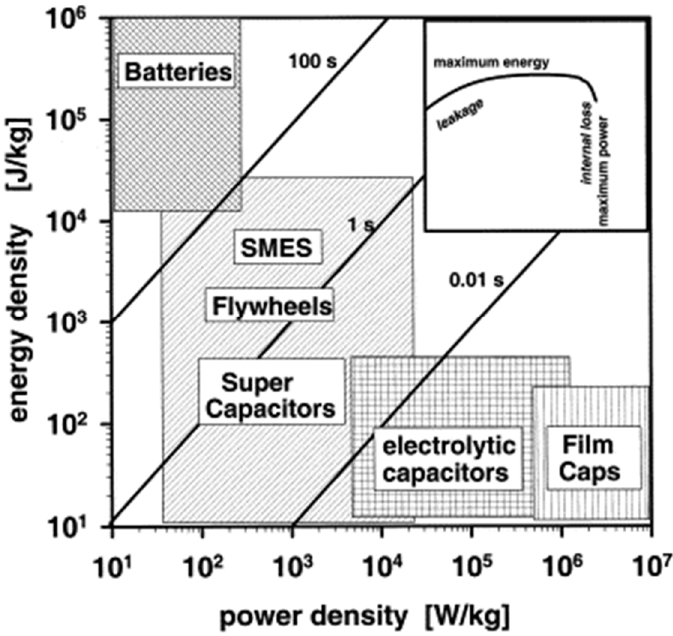
Figure 2. Ragone scheme showing energy loss owing to internal dissipation and leakage losses for sufficiently high and low power (reproduced from [46] with permission from Elsevier).